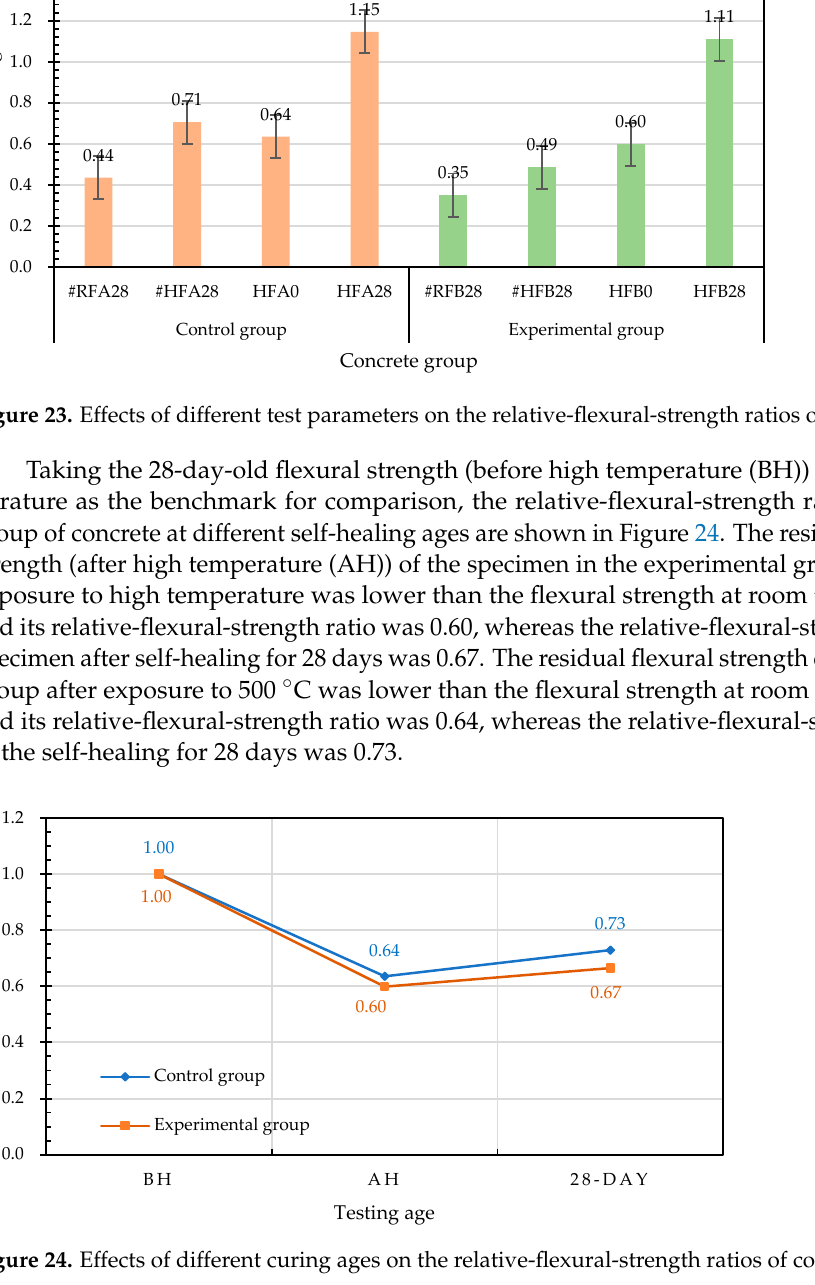
Figure 22. Effects of different test parameters on the flexural strengths of concrete.